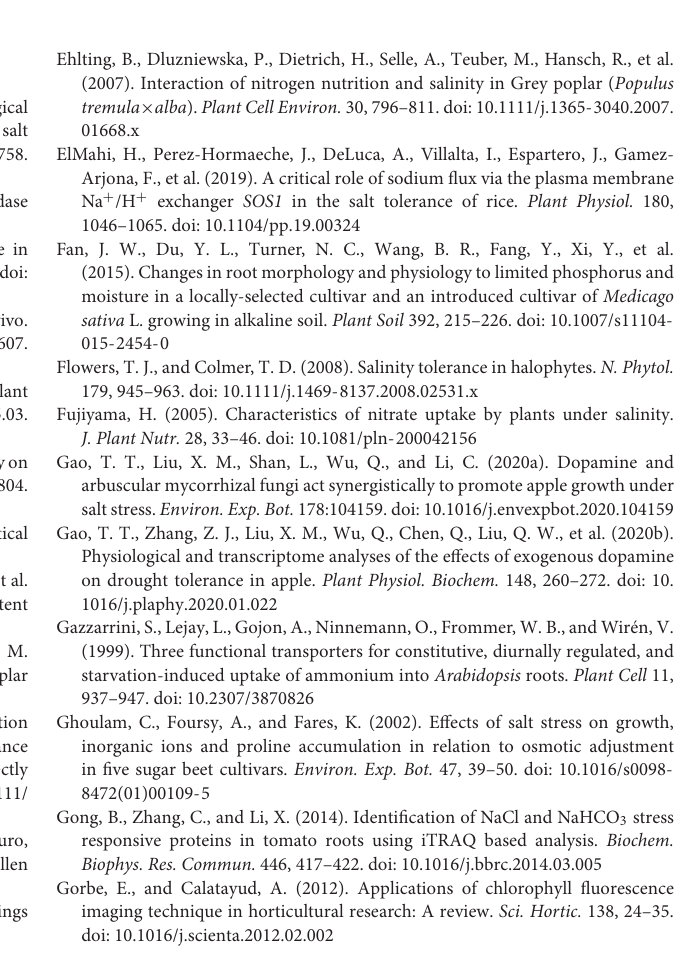
Supplementary Figure 1 | Dopamine content of MdTyDc -overexpressing apple plants after 5 days under control and alkaline conditions. (A) Dopamine content in leaves and (B) dopamine content in roots. The data are presented as means ± SD ( n = 3). Significant differences between WT and MdTyDc overexpression lines are indicated by different lowercase letters based on Tukey’s multi-range test ( P < 0.05). WT, wild type. OE-2, MdTyDc